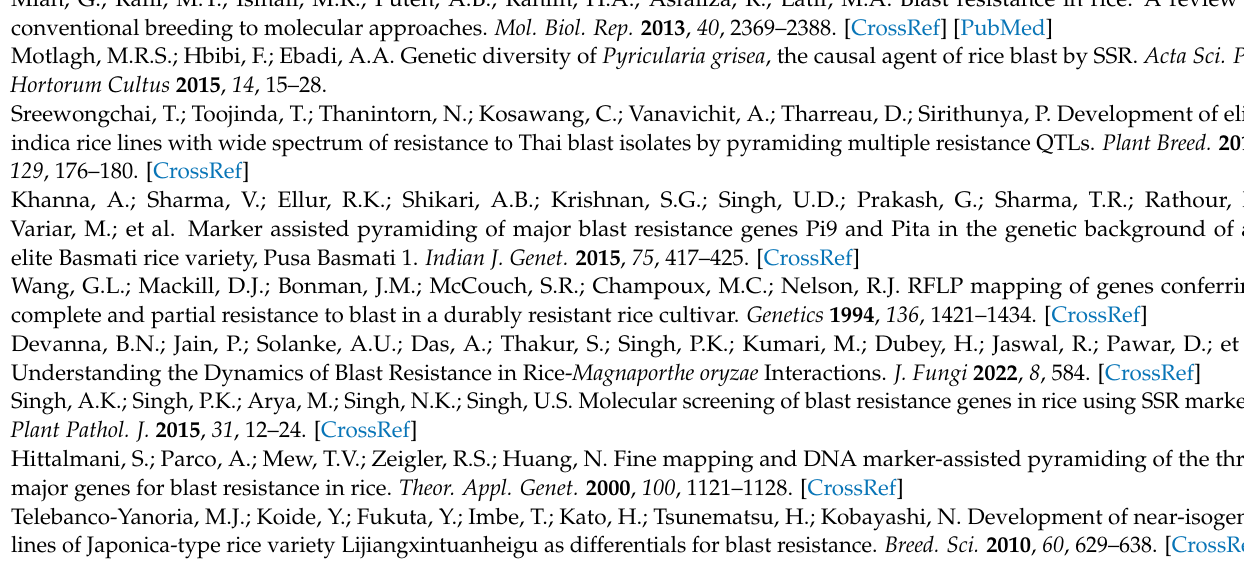
Table S1: List of 55 SSR markers used for background